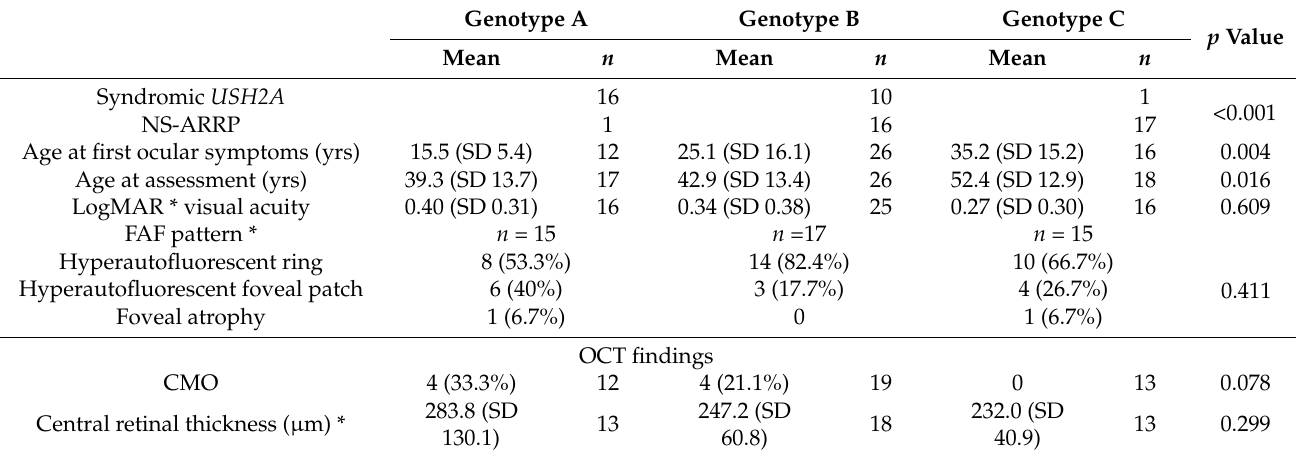
Table 2. Comparison between phenotypic severities between genotype groups of